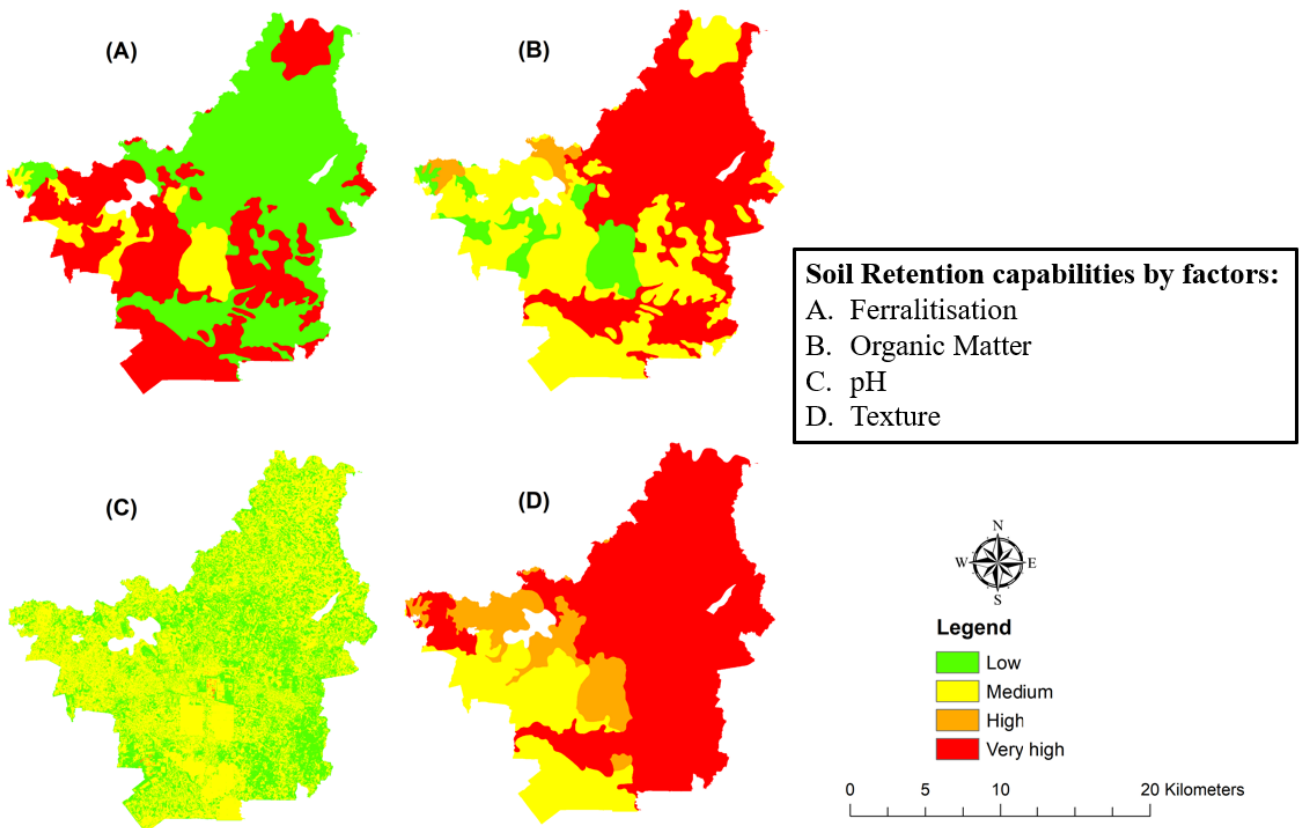
Figure 6. Maps show the levels of retention capability of Al 3+ of each criterion.